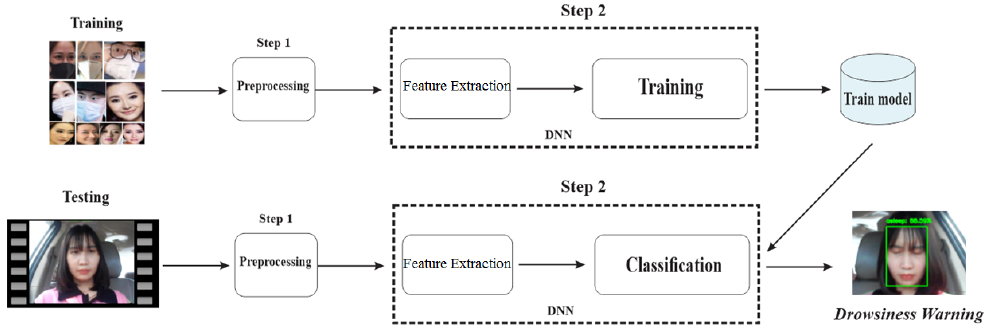
Figure 10. Model of the proposed method 2 for detecting drowsiness using deep